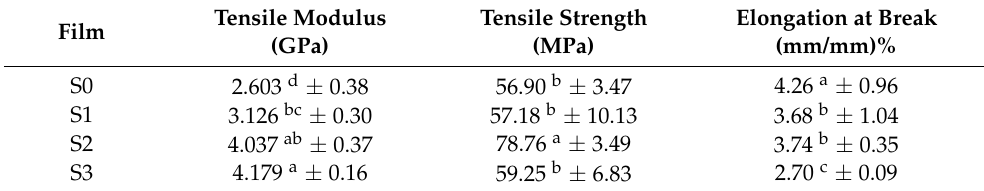
Table 3. Mechanical properties of S0~S3 films.